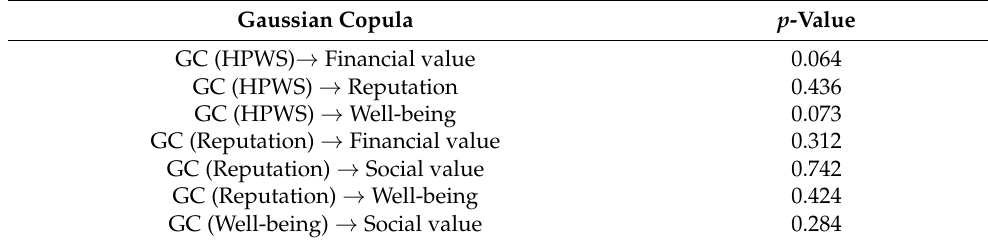
Table 4. Gaussian Copula Approach. (Source: our own based on